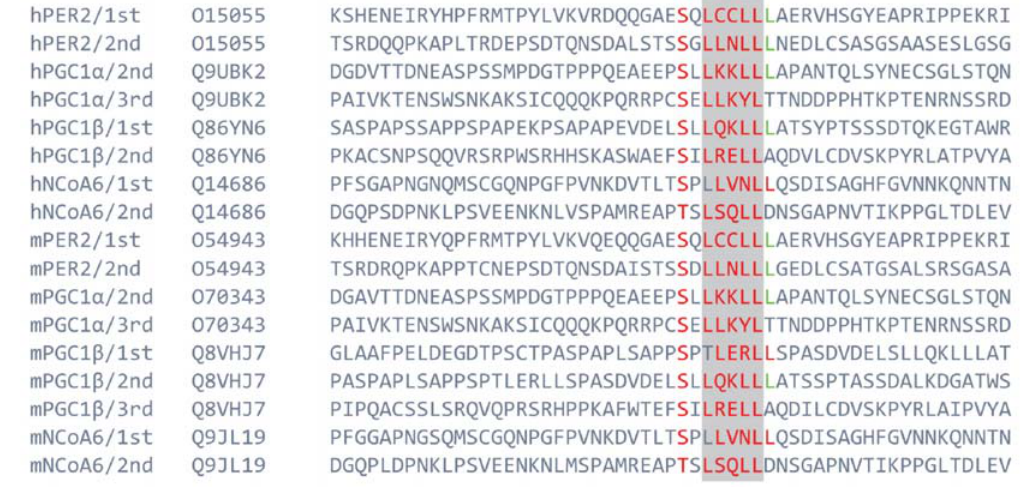
Figure 2. Alignment showing similarity between PER2 and known co-activator LXXLL motifs of CAR , namely PGC1alpha, NCoA6 and PGC1beta. 28,30 The letters h and m before the protein name designate species Homo sapiens and Mus musculus , with the sequential number of the noted LXXLL and UniProt/Swiss-Prot entry number following the protein name. The predicted LXXLL motifs with residues marked as 1-5 are shown in red, as are serines located just before LXXLL. Of note is a negatively charged side-chain, or a hydroxyl group containing residues (E, S, T) just in front of the -2 serine.